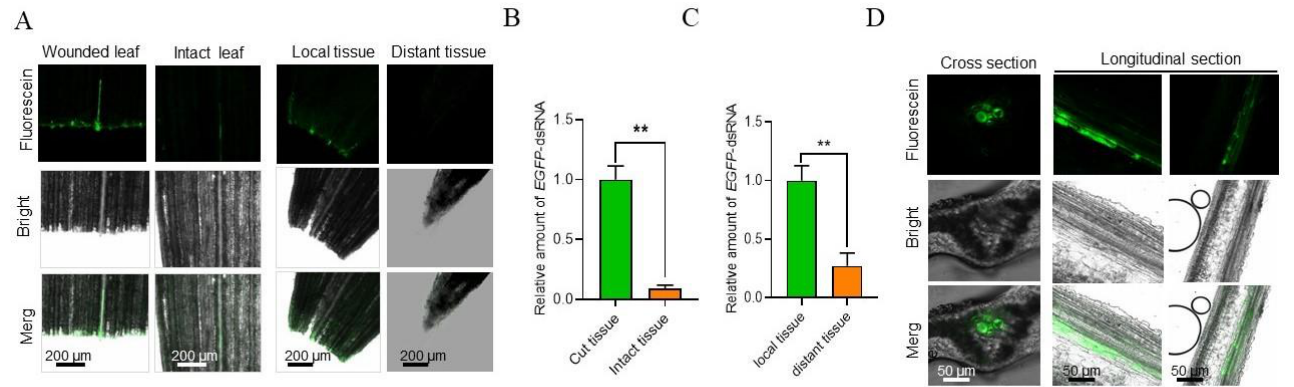
Figure 4. DsRNA uptake by maize leaves and transportation in the vascular system. ( A ) Fluorescein- labeled EGFP -dsRNA uptake by wounded and intact maize leaves. Detection of fluorescein signals in leaves 24 h after dsRNA spraying. ( B ) Amounts of EGFP -dsRNA in the wounded and intact maize leaves 24 h after spraying. ( C ) Amounts of EGFP -dsRNA in local and distant tissues of maize leaves 24 h after spraying. ( D ) Transportation routes of EGFP -dsRNA in maize leaves. Leaf cross sections were examined for fluorescein signals in the vascular system, including the phloem and xylem cells. Longitudinal sections of leaves for observation of fluorescein signals in transportation routes: from epidermal cells to vascular cells and from local to distant sites in the vascular system. **, p < 0.01.